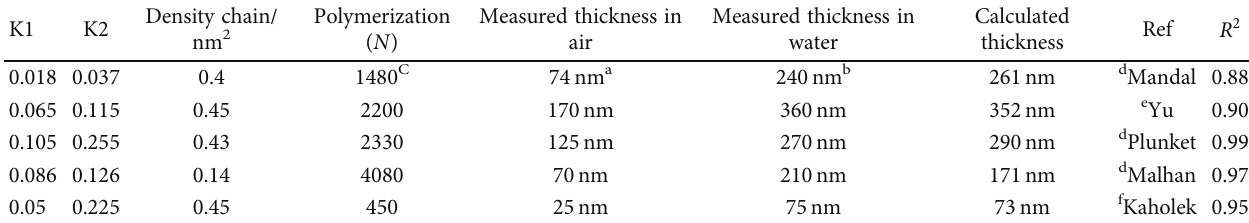
Table 1: Calculated k1 and k2